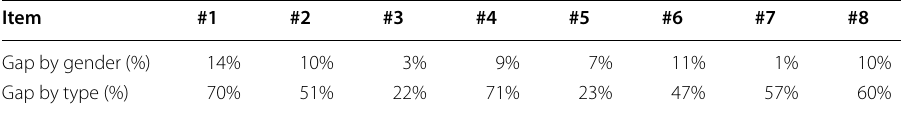
Table 2 Gender gap (difference in percent correct) by real gender and gender-specific response